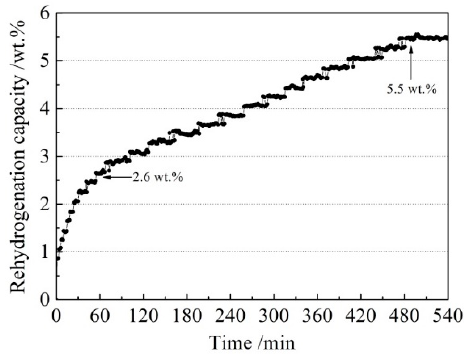
Figure 8. The rehydrogenation curve of the dehydrogenated LiBH 4 / Al* sample under 8 MPa H 2 at